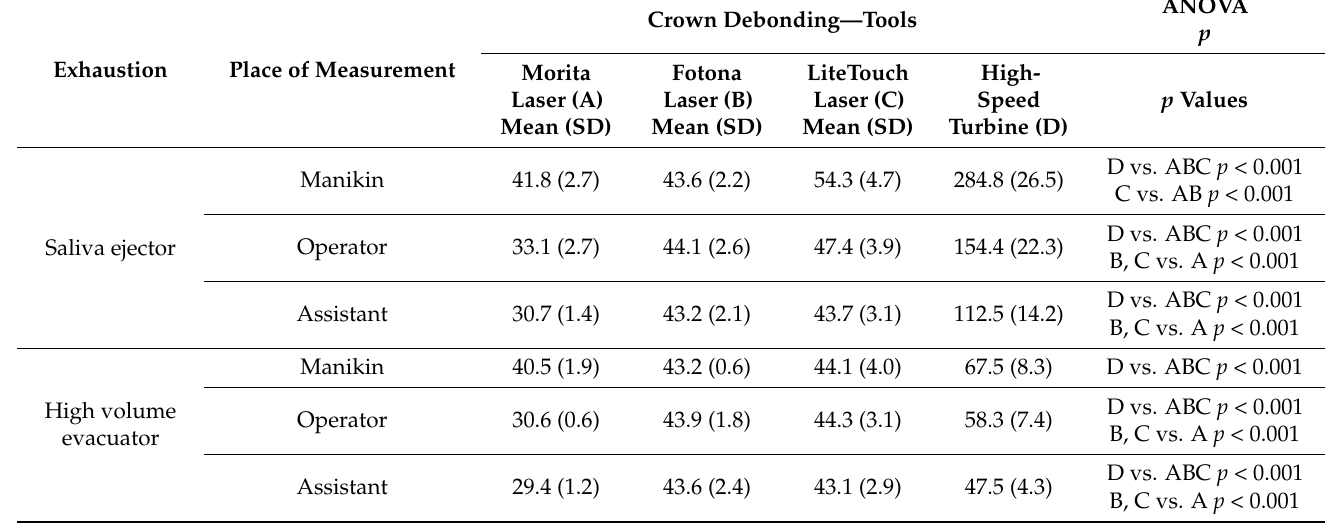
Table 3. The level of aerosol particles ( × 103) measured at manikin, operator, and assistant mouths (Mean (SD)) during ceramic crown